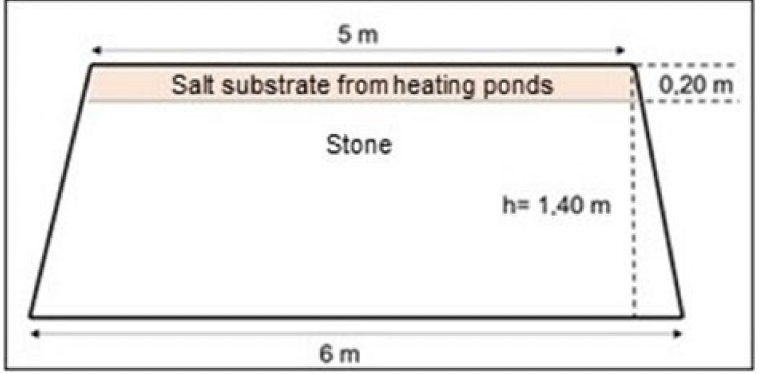
Figure 4. Construction profile of the salt pond separation dike (Source: own